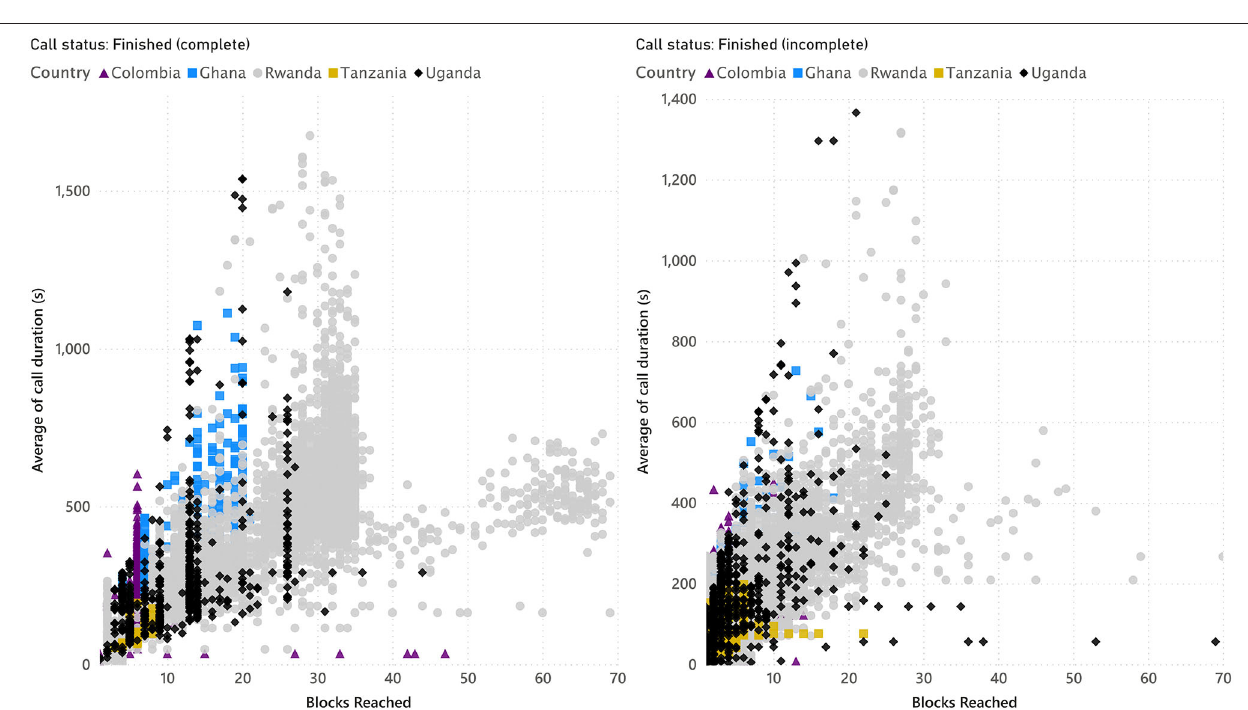
FIGURE 7 | Blocks reached an average of call duration by call duration and country; calls complete (left) and incomplete (right).